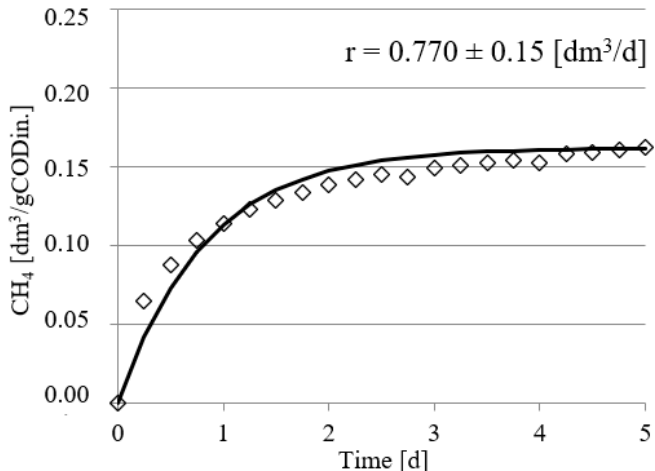
Figure 2. Course of methane fermentation in series 1.